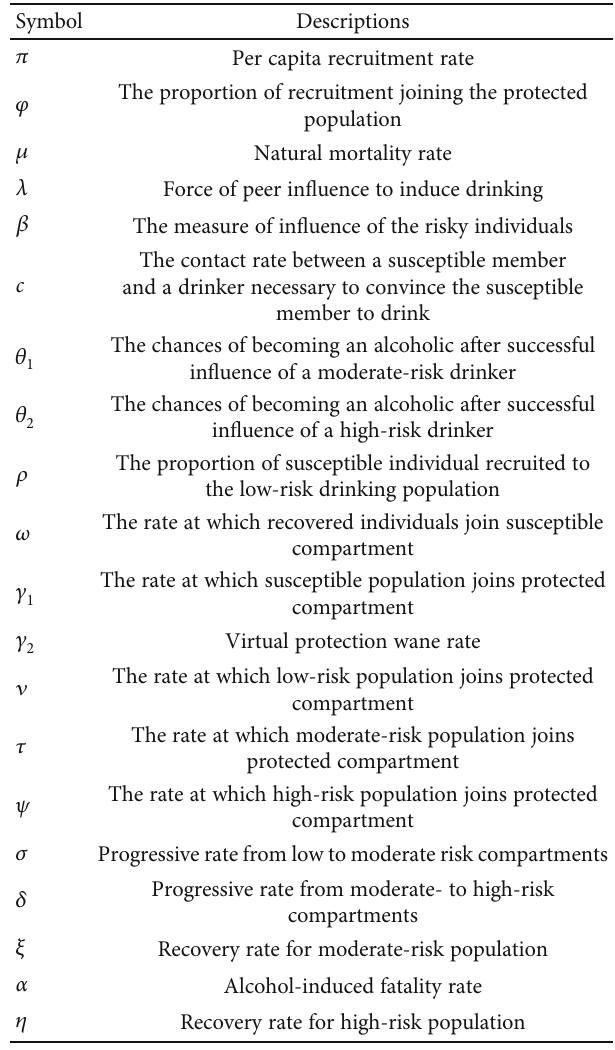
Table 1: Model parameters and their